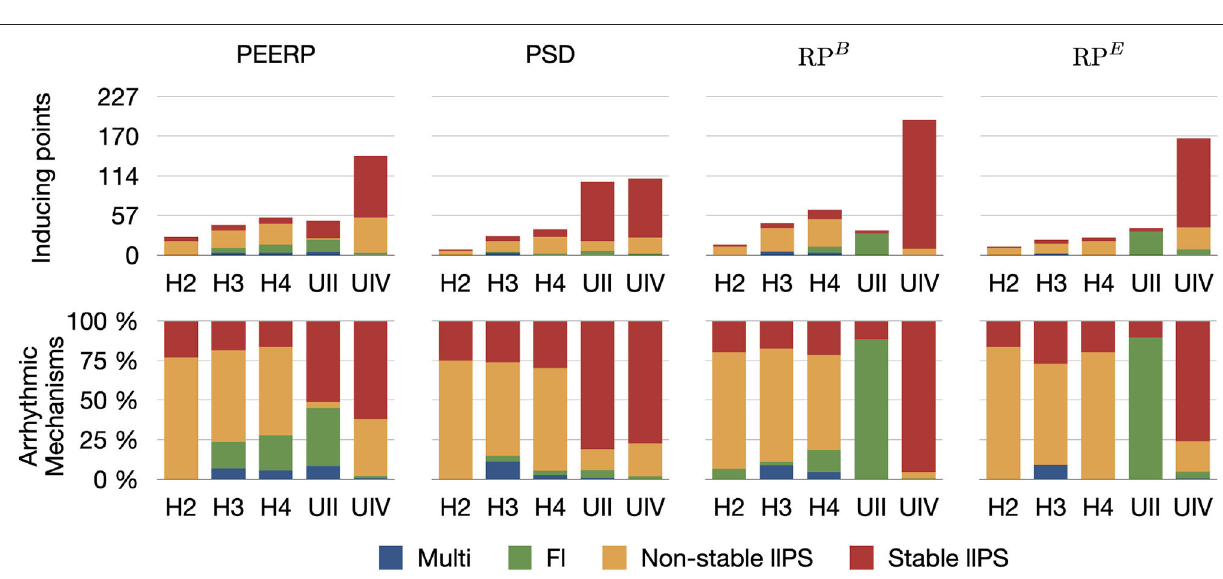
FIGURE 4 | First row: number of inducing points classified per induced arrhythmic mechanism: multiple wave fronts, flutter, non-stable and stable long living phase singularity. Second row: arrhythmic mechanisms induced by each protocol in the different atrial